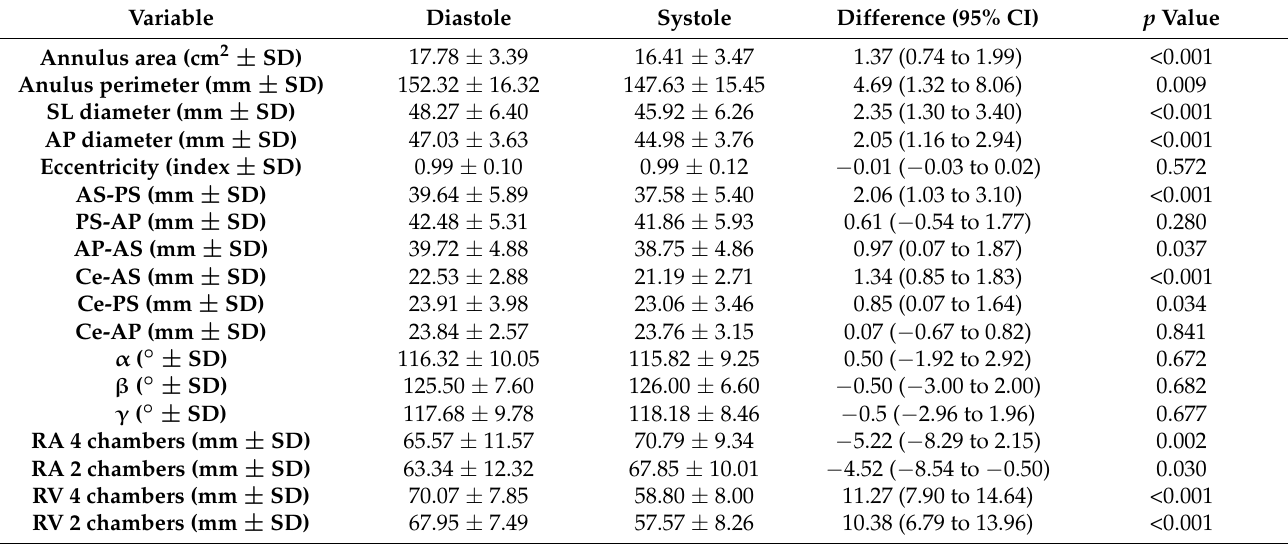
Table 2. Tricuspid annulus measurements and differences between diastole and